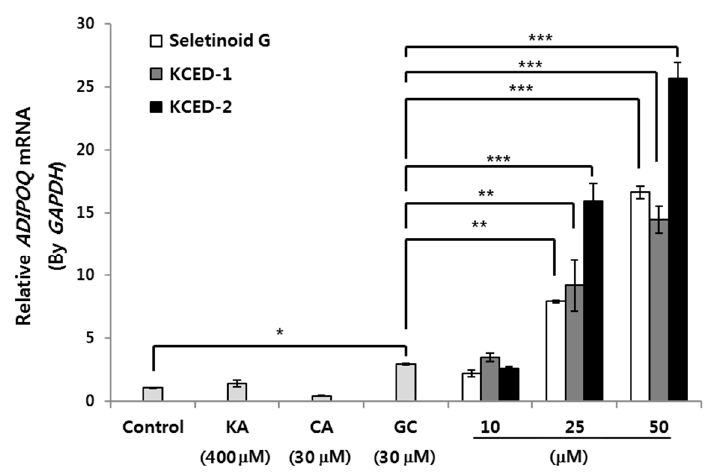
Figure 3. Upregulation of ADIPOQ mRNA expression by SG, KCED-1, and KCED-2 in hSCFs. The hSCFs were treated with the indicated concentration of each compound for 14 days, and the mRNA expression of ADIPOQ was analyzed by qRT-PCR. The data are presented as the mean ± SD ( n = 3; * p < 0.05, ** p < 0.01, and *** p < 0.001). KA, kojic acid; CA, cinnamic acid; GC, glibenclamide.